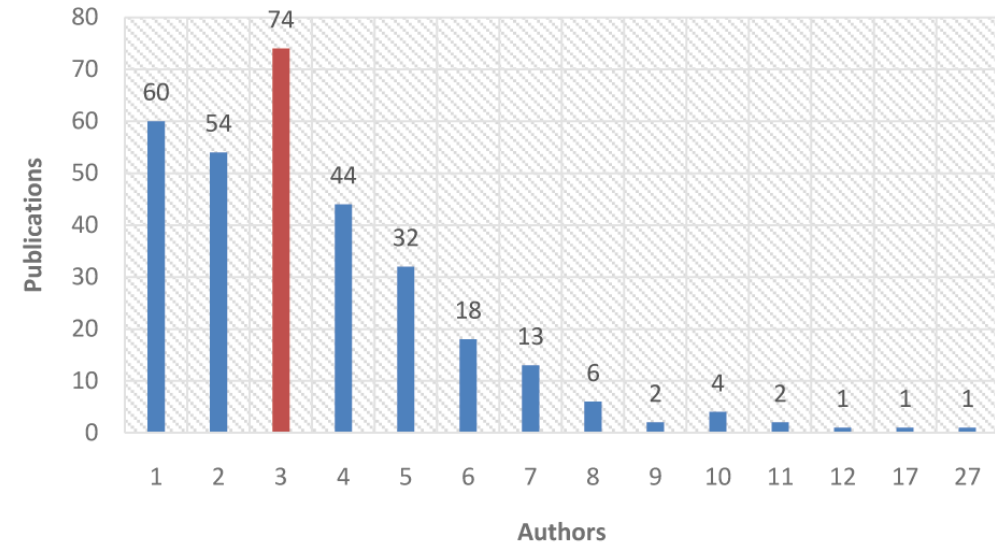
Figure 6. Number of Authors in RTI publications in the GCC region (1981–2019). (generated using Microsoft